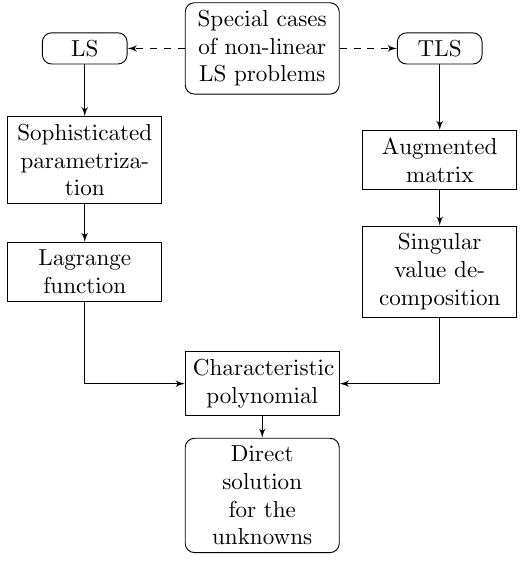
Figure 1: Flowchart for two possible direct solutions of non-linear LS